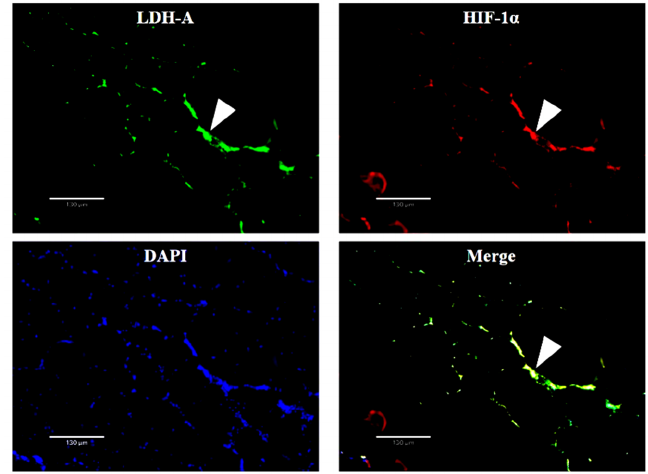
Figure 7. The double in situ hybridization (D-ISH) result of LDH-A and HIF-1 α RNA in skeletal muscle. Green fluorescence ( upper left ) and red fluorescence ( upper right ) represent LDH-A mRNA and HIF-1 α mRNA, respectively. The yellow-green fluorescence ( bottom right ) indicates the location of these two mRNA. Nuclei are shown by blue fluorescence ( bottom left ). The three arrows show that these two mRNA are located at the same position.